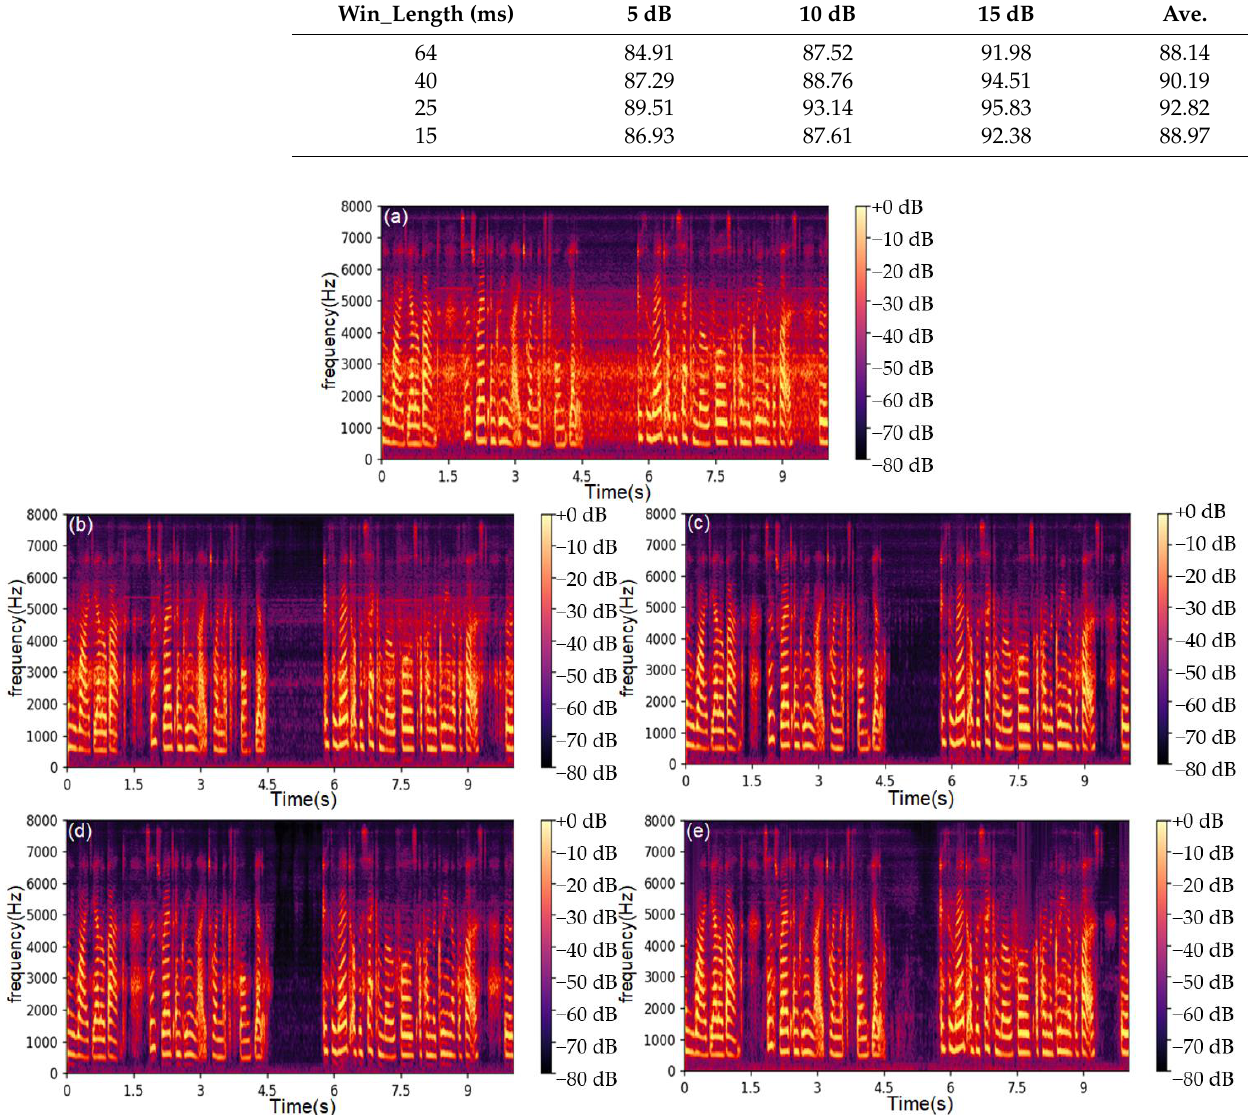
Table 4. The STOI (in %) scores for models with different window lengths.